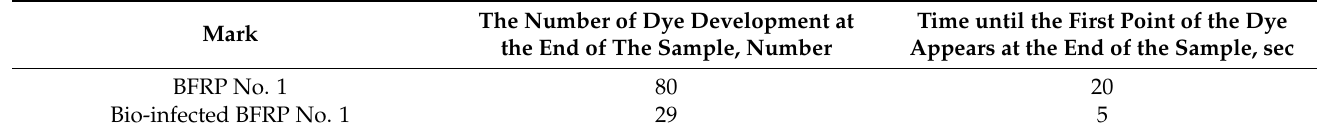
Table 9. Results of testing the exposed samples for solidity before and after bio-infection and exposure in Yakutsk.